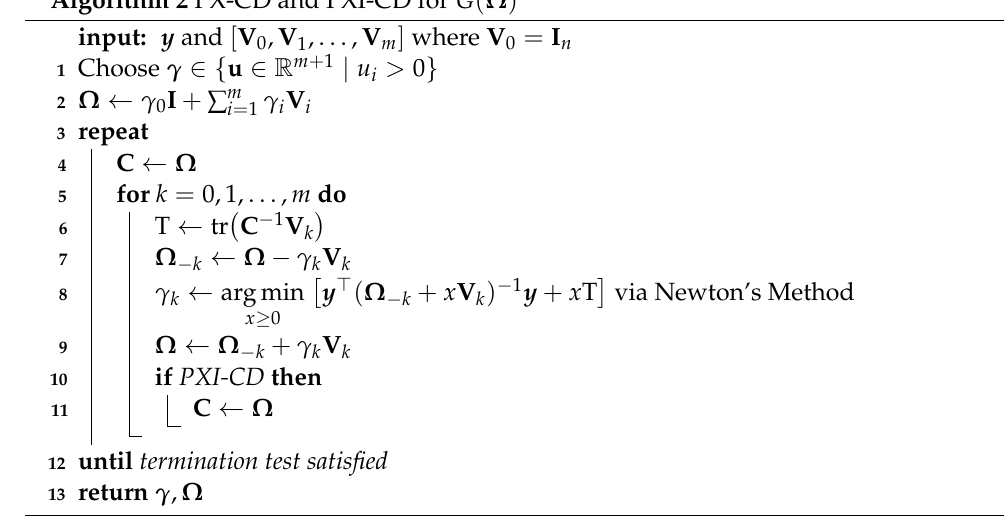
Algorithm 2 PX-CD and PXI-CD for G ( Ω